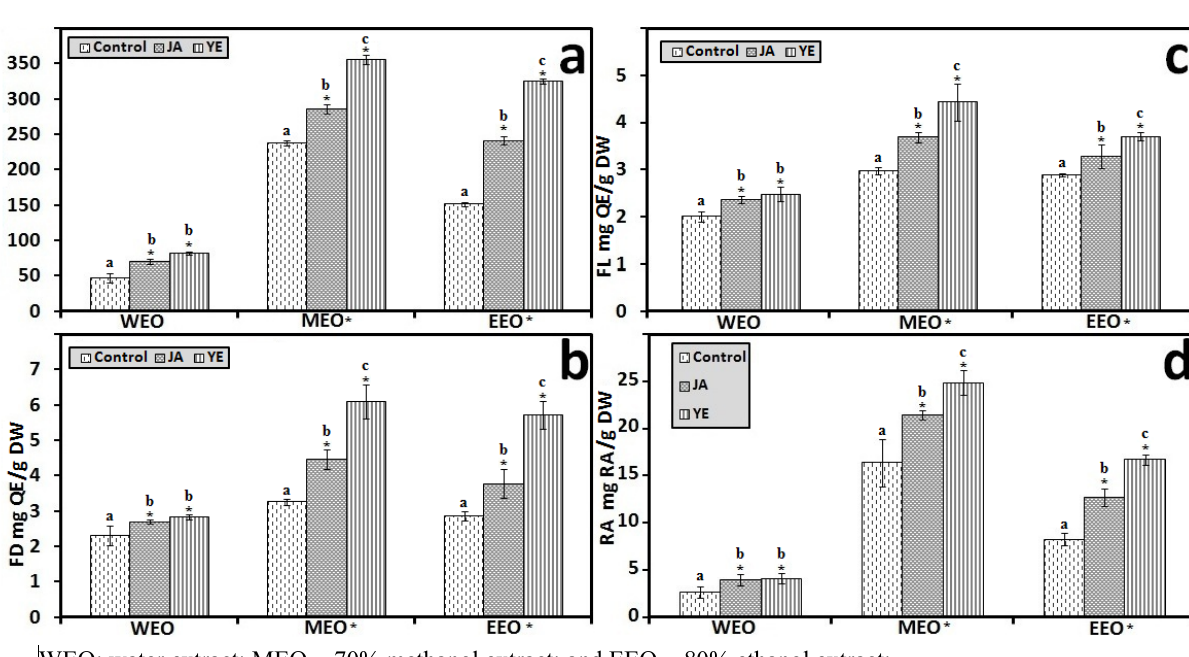
Figure 3. Antioxidant components of the IOSC subjected to elicitation using three different solvents for extraction ( a ) total phenolics ( Phe ); ( b ) flavonoids ( FD ); ( c ). flavonols ( FL ); ( d )